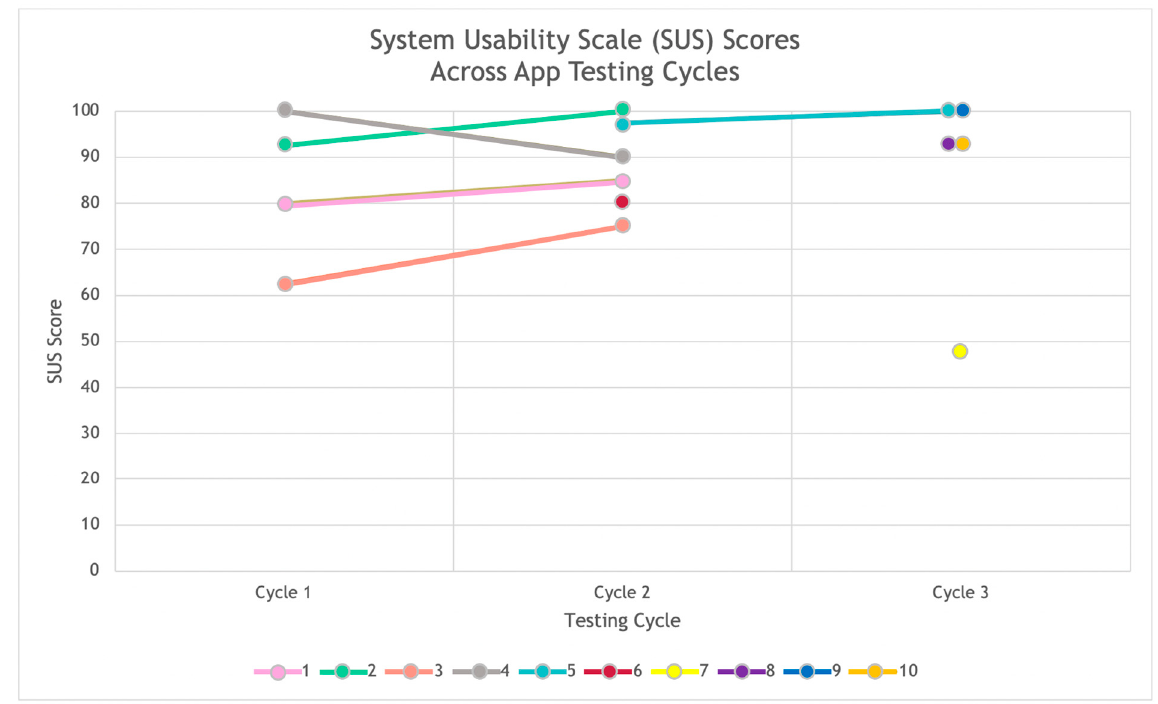
Figure 3. System Usability Scale (SUS) Scores Across App Testing Cycles. Each dot color represents one participant. Higher total scores (calculated as a proportion score/100) indicate higher usability: ≥ 85 = Excellent; ≥ 71 = Good; ≥ 51 = Okay (Bangor et al. 2008).